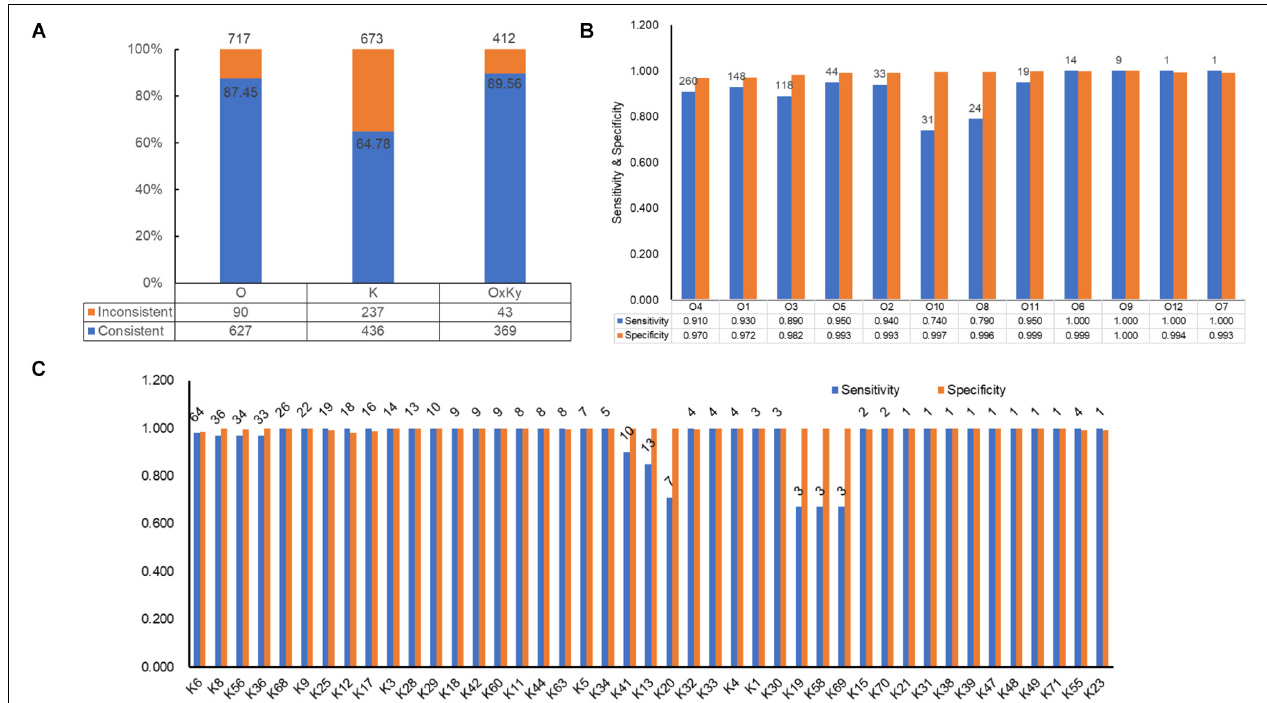
FIGURE 3 | Identification performance of VPsero. (A) Consistency between serological determination and VPsero in silico identification by O and K serogroups and serotypes. (B) Sensitivity and specificity of VPsero in identification of 12 O serogroups. (C) Sensitivity and specificity of VPsero in identification of 43 K serogroups. Total numbers of strains tested in (B,C) are as indicated above for each serogroup.